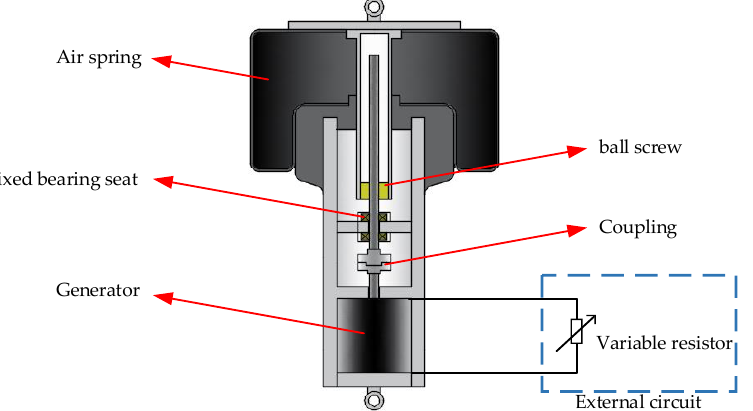
Figure 1. The schematic diagram of A-EMD.